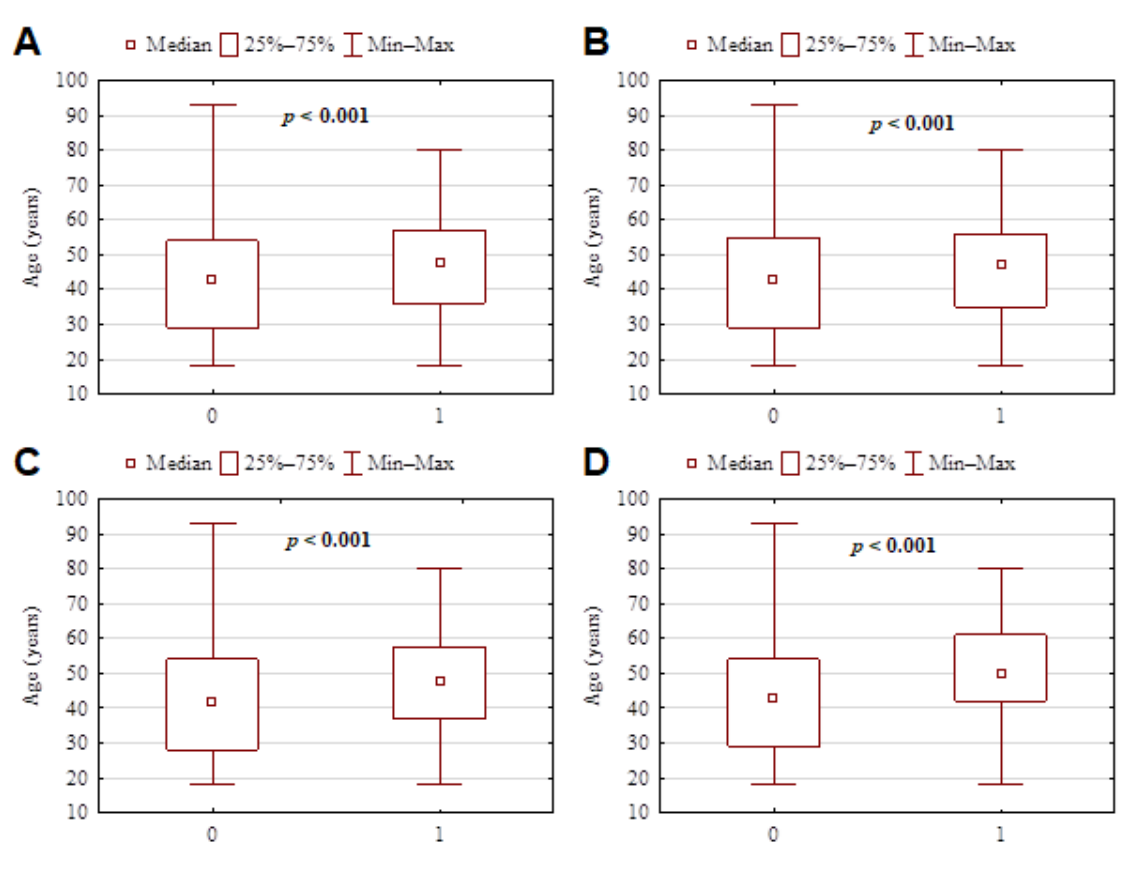
Figure 2. Questionnaire significant results according to the age of subjects. ( A ) Postponing a dental visit and the age of patients indicated that older subjects frequently postponed the appointment.